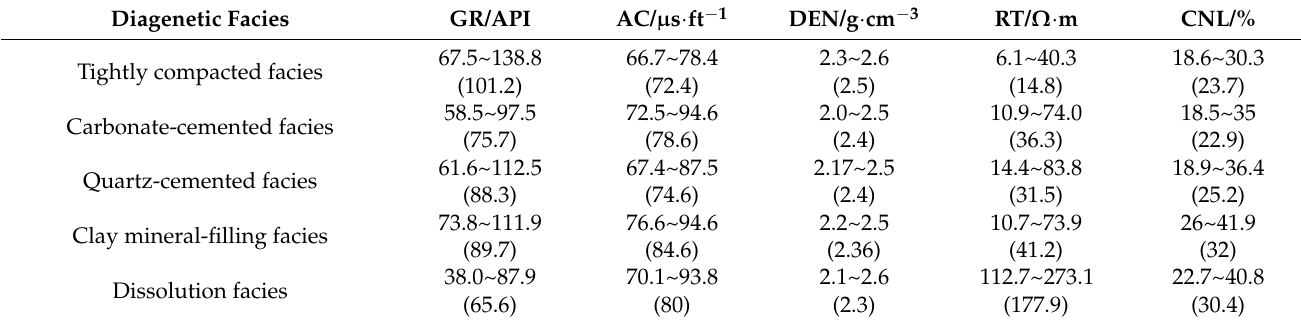
Table 2. Characteristics of different diagenetic logging